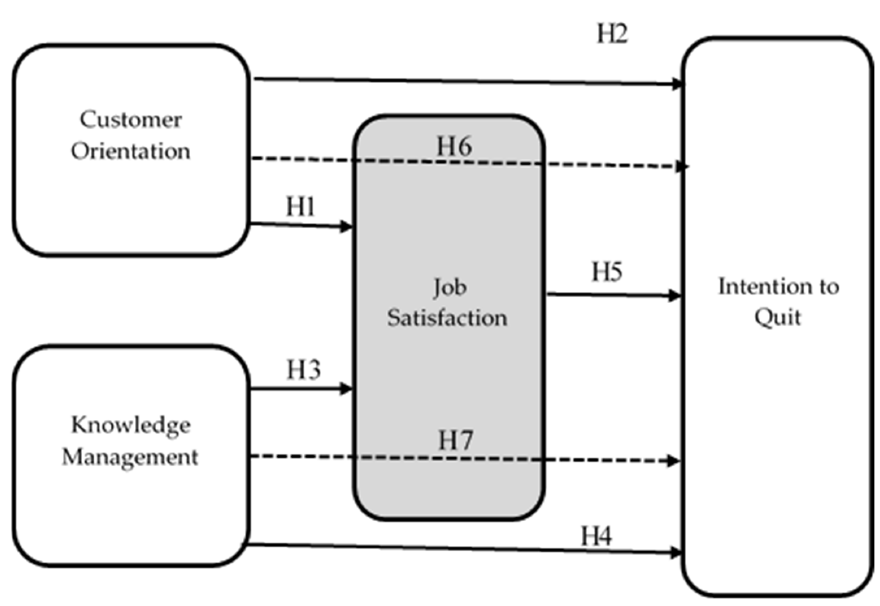
Figure 1. Conceptual framework.